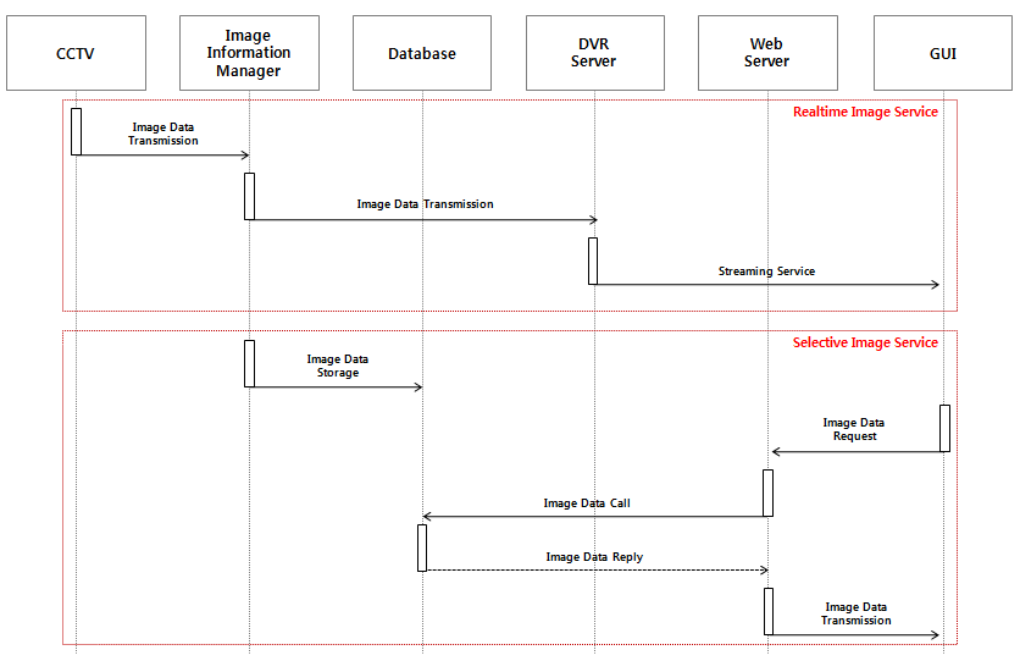
Figure 3. Operation Process of the Image Monitoring Service.